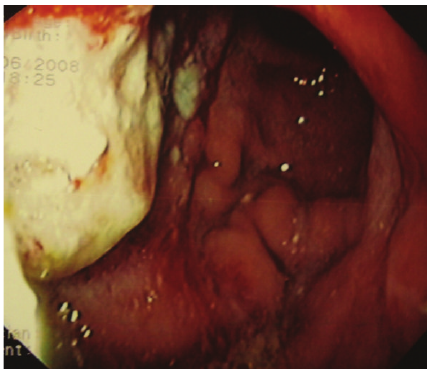
Figure 2: Endoscopy revealed two gastric ulcers. Biopsy revealed a DLBCL.